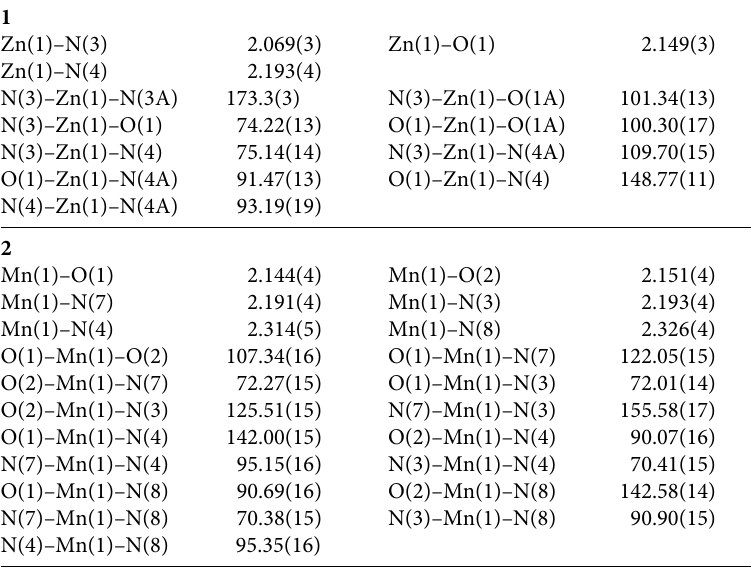
Table 2. Selected bond lengths (Å) and bond angles (º) for complexes 1 and 2